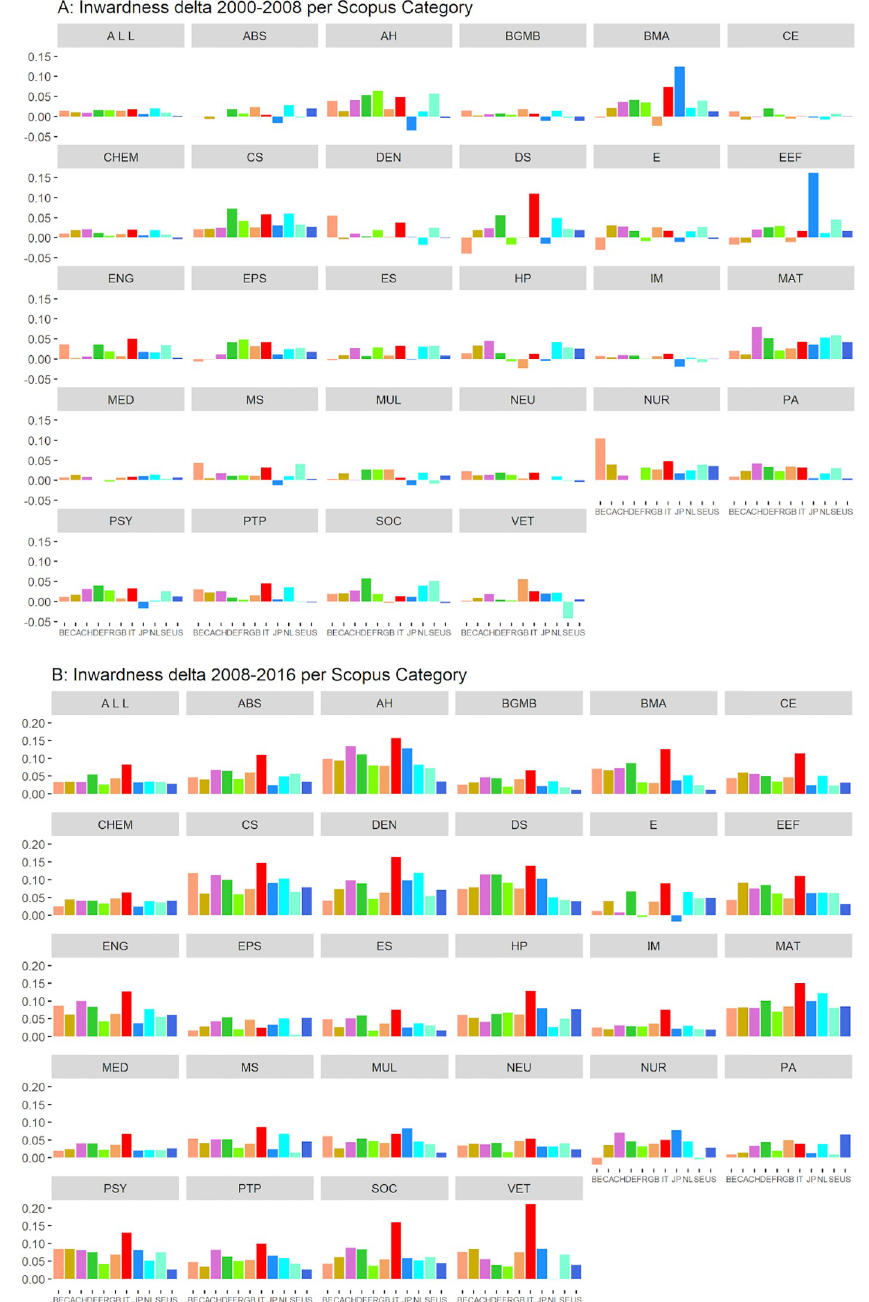
Fig 3. Inwardness delta in Scopus Main Categories in the periods 2000-2008 (A) and 2008-2016 (B). ABS = Agricultural and Biological Sciences, AH = Arts and Humanities, BGMB = Biochemistry, Genetics